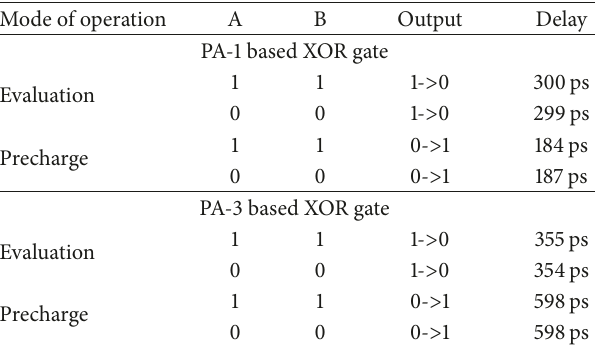
Table 5: Delay measurement for the PA-1 based and the PA-3 based ED-CVSL XOR/XNOR